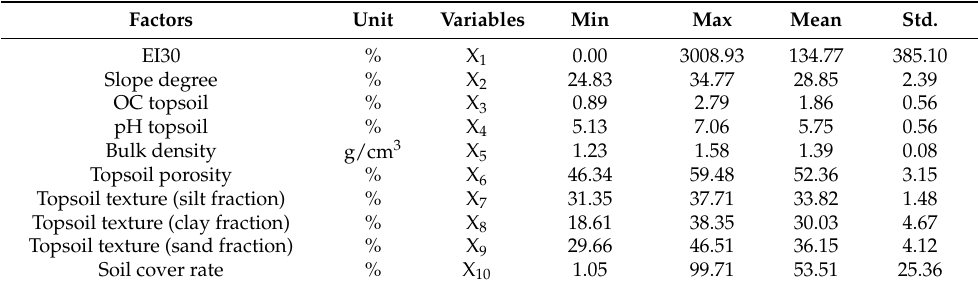
Table 1. Influencing factors of soil